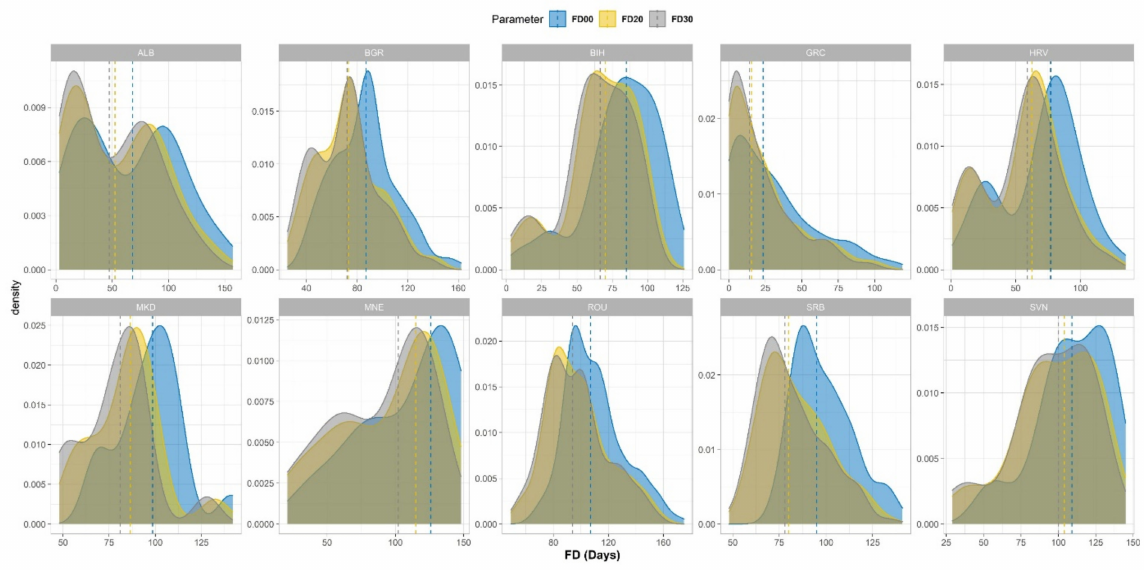
Figure 5. The density plots of the Frost Days (FD) for the reference period and the 2020 and 2030 horizons, per country. The vertical lines represent the median